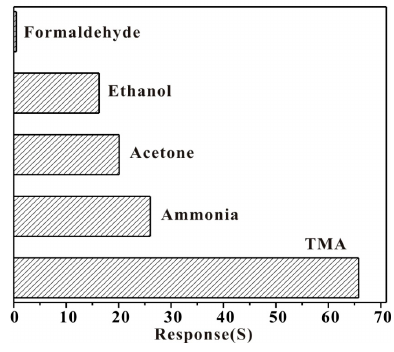
Figure 11. Response comparison of 30 ppm of TMA and 30 ppm of other volatile organic compounds (VOCs) at 260 °C. Table 1. Properties of gas molecules.